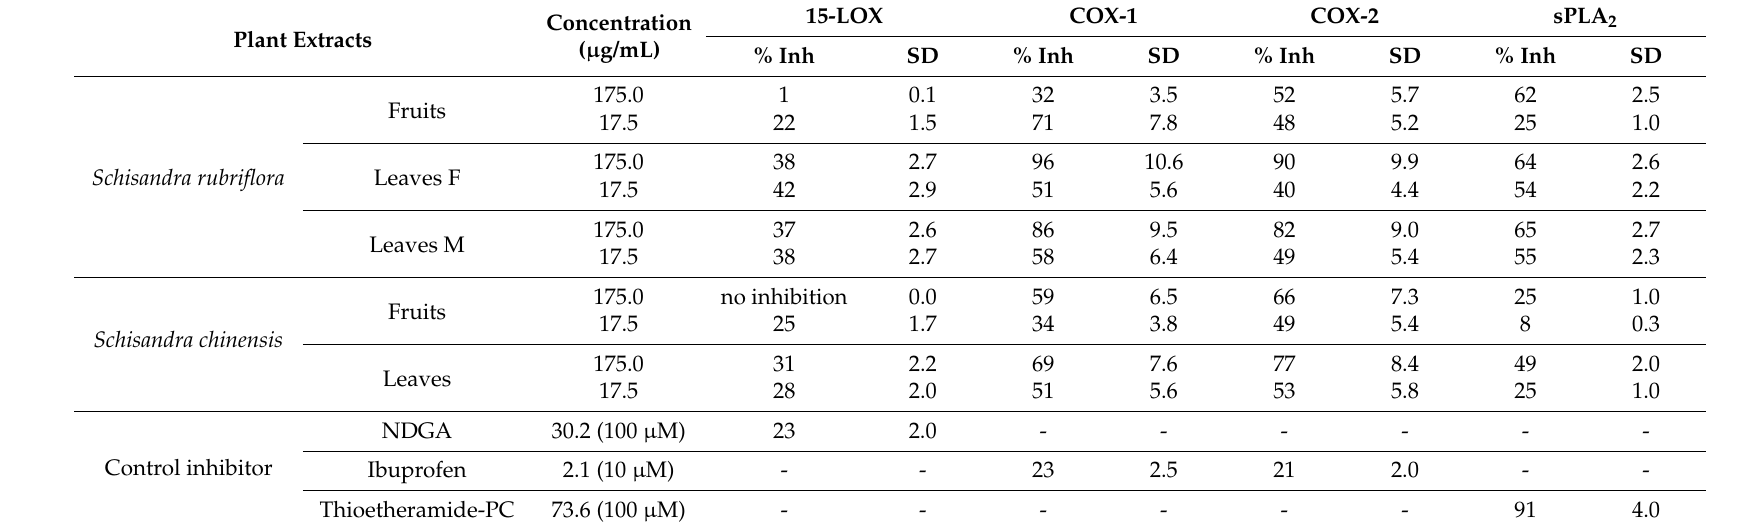
Table 3. In vitro inhibition activity of studied S. rubriflora and S. chinensis extracts solutions against 15-LOX, COX-1, COX-2, and sPLA 2 . Plant Extracts